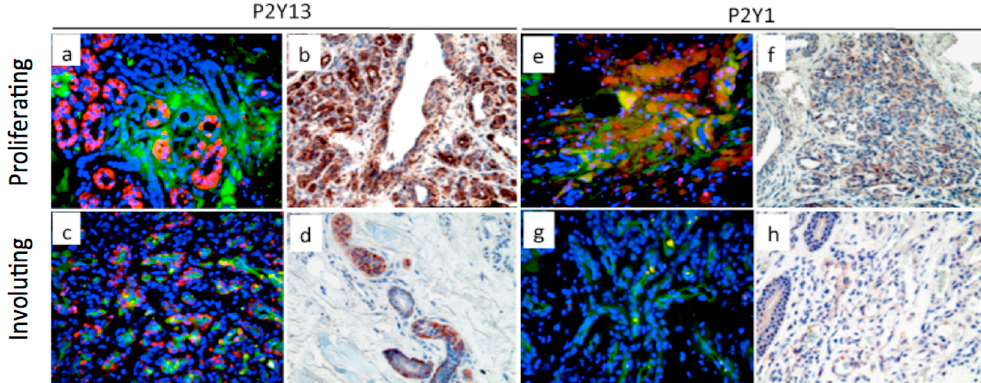
Figure 5. P2Y13 and P2Y1 receptor expression in proliferating and involuting infantile hemangiomas. ( a , c , e , g ): Double immunofluorescent analysis for P2Y13 and P2Y1 receptors (Alexa 594, red) and PECAM / CD31 (Alexa 488, green); nuclei were counterstained with DAPI (blue; Carl Zeiss, x40 magnification; ( b , d , f , h ): Immunohistochemical analysis for P2Y13 and P2Y1 receptors (AEC substrate, Olympus, X40 magnification). Tissue sections were kindly provided by Dr. Sule Cataltepe (Children’s Hospital, Boston, MA, USA).